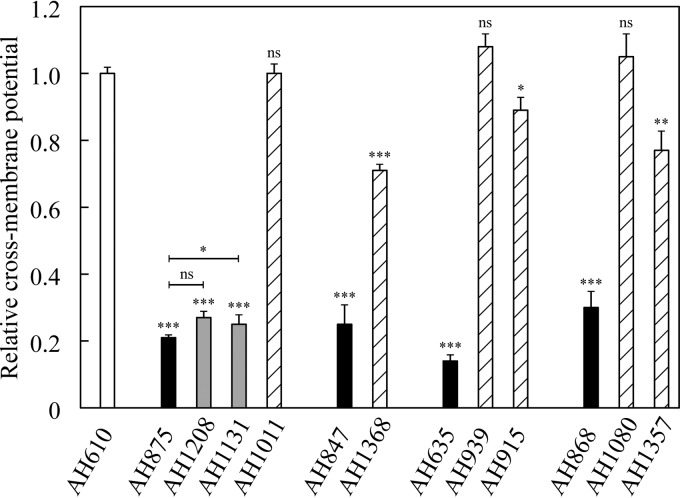
Relative cross-membrane potential of the wild type, SCVs, and growth-compensated mutants. All values are relative to the cross-membrane potential of the wild type (white). Relative cross-membrane potentials of menadione-auxotrophic SCVs (AH875, AH847, and AH635) and hemin-auxotrophic SCV (AH868) are shown in black. Isogenic evolved mutants that additionally carry transcriptional SCV suppressor mutations affecting srrB (AH1131) and srrA (1028) are shown in gray, and translational SCV suppressor mutations affecting tRNA genes (AH1011, AH939, AH915, and AH1080), RF2 (AH1368), or S5 (AH1357) are hatched. Unless otherwise indicated, all significance values (t test) are compared to the wild-type cross-membrane potential. ns, nonsignificant; *, P < 0.05; **, P < 0.01; ***, P < 0.001.